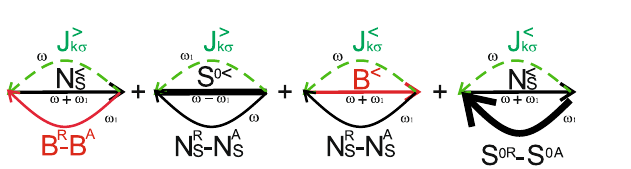
Figure 6. Leading diagrams contributing to the zero frequency noise in the S